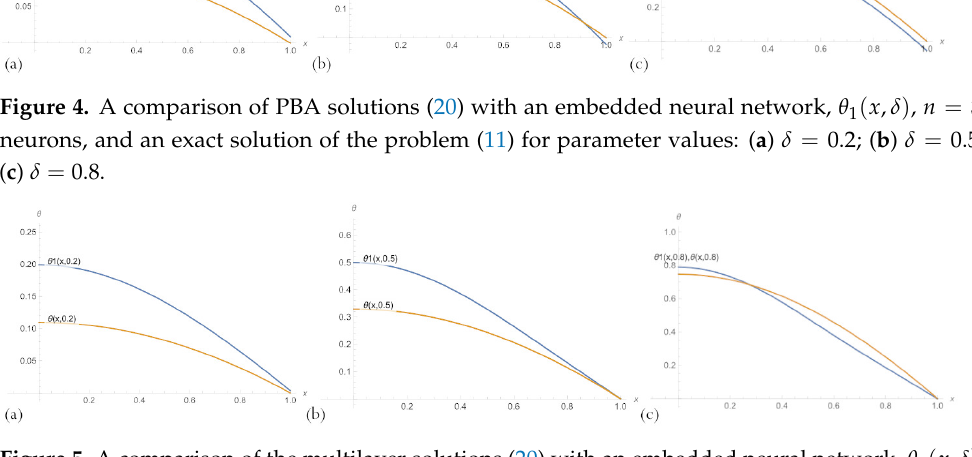
Figure 5. A comparison of the multilayer solutions (20) with an embedded neural network, θ 1 ( x , δ ) , n = 10 neurons, and an exact solution of the problem for parameter values: ( a ) δ = 0.2; ( b ) δ = 0.5; ( c ) δ = 0.8.